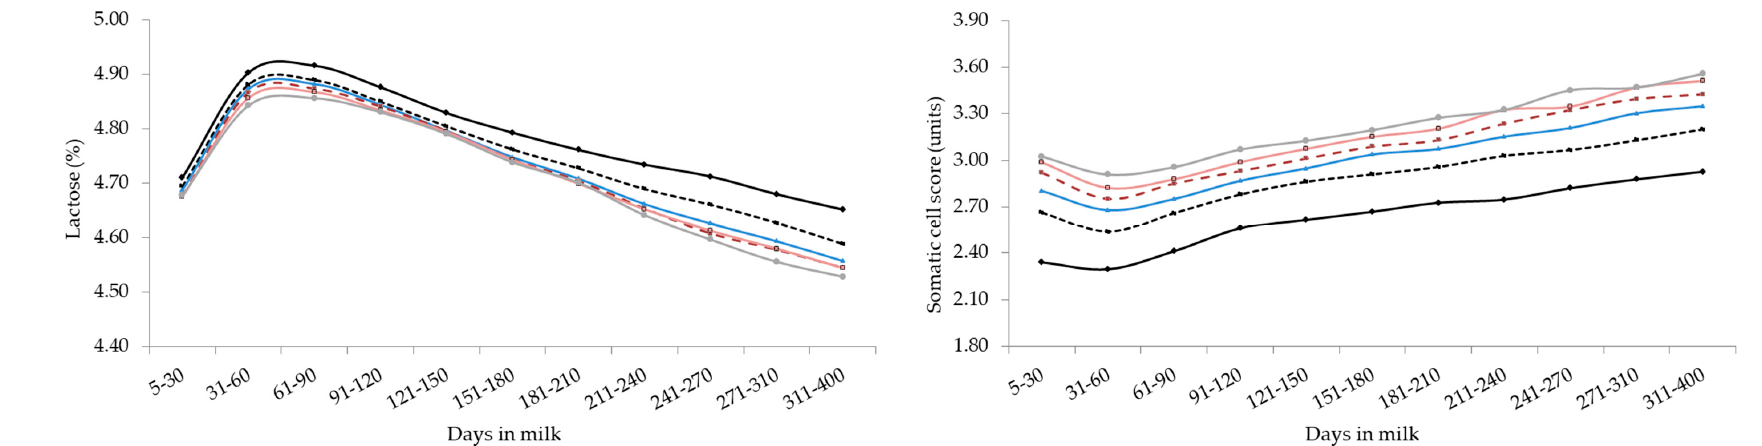
Figure 2. Least square means of milk yield, energy corrected milk, composition traits, and somatic cell score for the interaction effect of stage of lactation and parity. Standard errors were within the following ranges: 0.018–0.062 (milk yield), 0.056–0.197 (energy corrected milk), 0.011–0.038 (fat), 0.003–0.010 (protein), 0.002–0.008 (lactose) and 0.013–0.041 (somatic cell score).